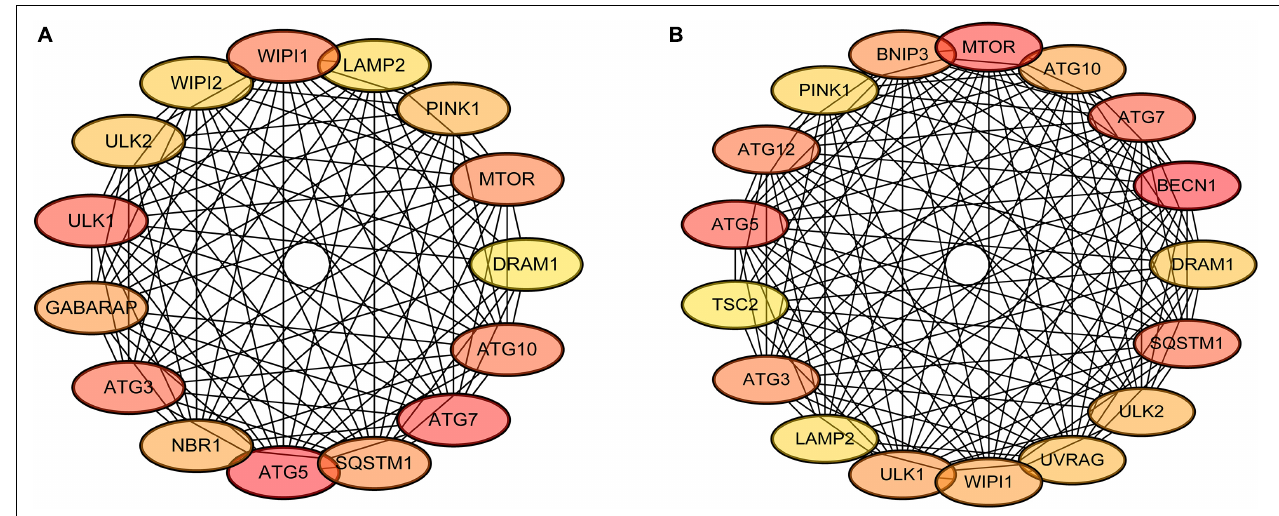
FIGURE 5 | Protein-protein interaction (PPI) network construction and major autophagy-related genes. The cytoHubba plugin was used to analyze the top 20 percent of the hub genes with maximum correlation criterion in mild (A) and severe (B) presbycusis.